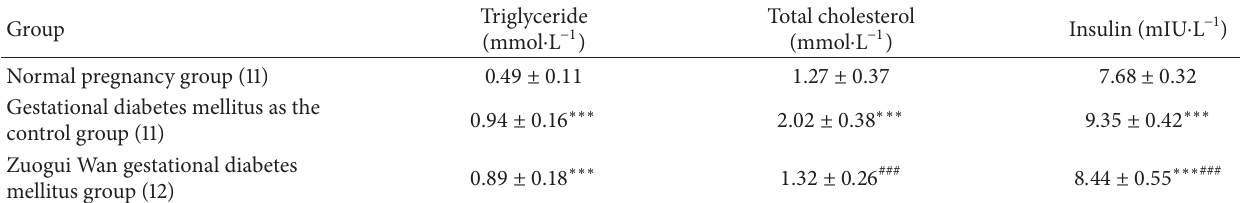
Table 3: Impact of Zuogui Wan on biochemical index in rats of gestational diabetes mellitus.